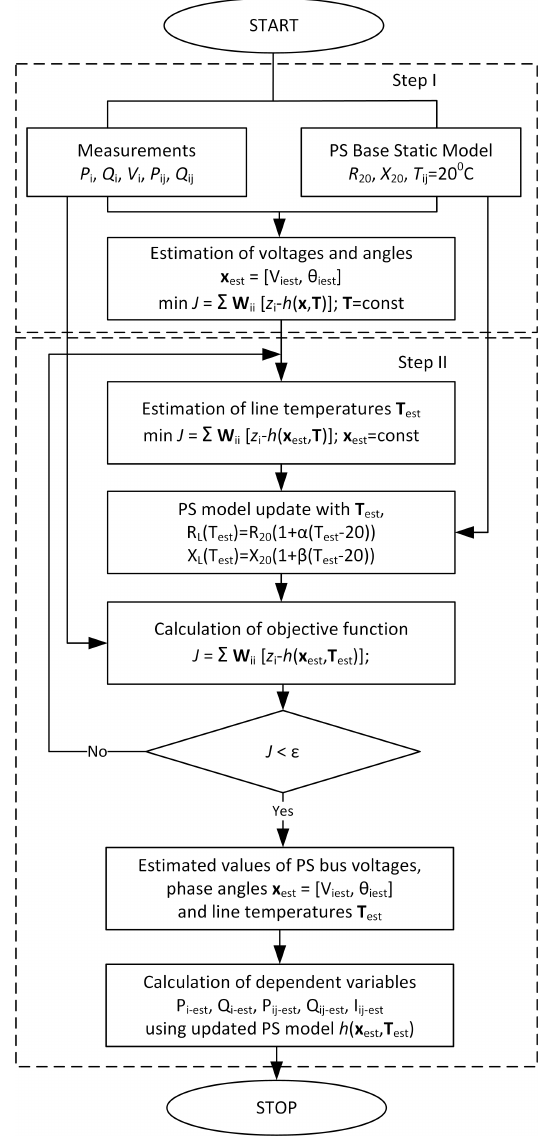
Figure 3. Algorithm of the two-step power system state and line temperature